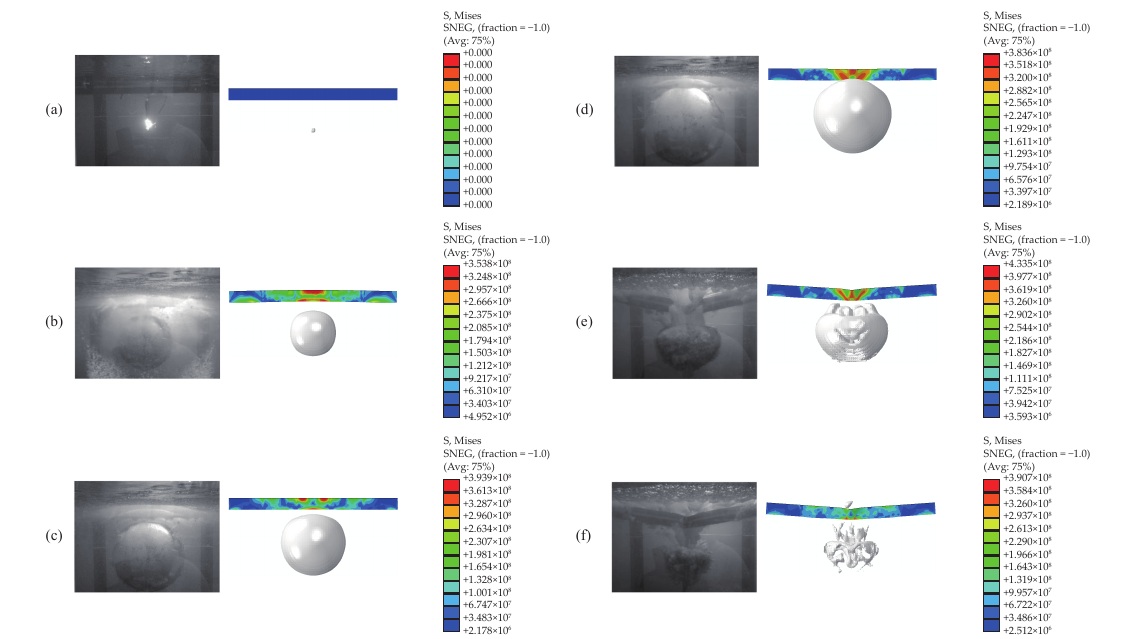
Figure 4. Comparison between experimental photos [23] and calculated cloud pictures: ( a ) 0 ms, ( b ) 5 ms, ( c ) 11 ms, ( d ) 20 ms, ( e ) 45 ms, ( f ) 55 ms.